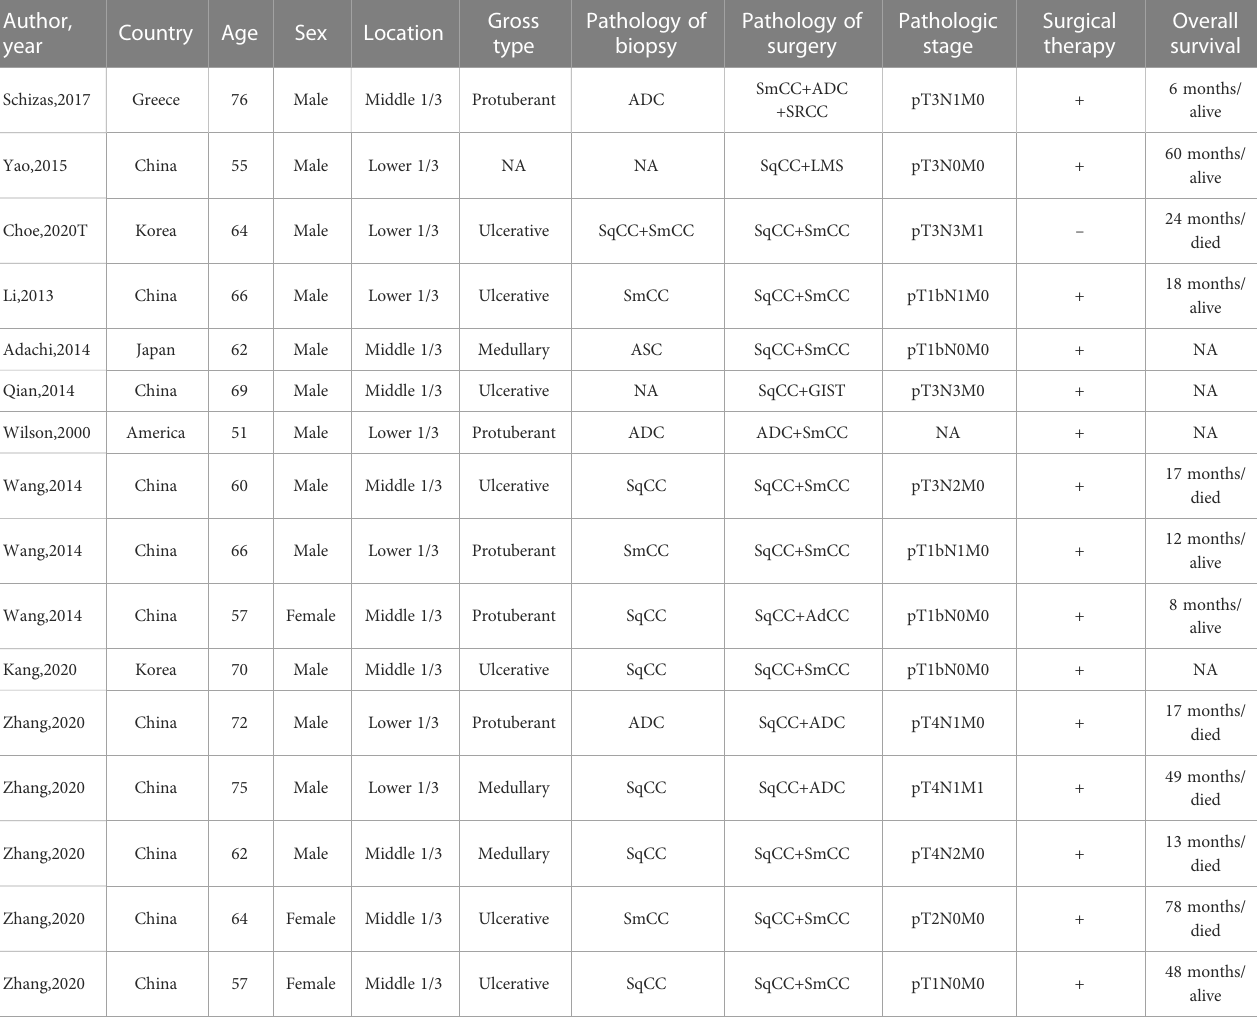
TABLE 1 Clinical Characteristics, Pathology, and Treatment Options of Esophageal Collision Tumors.